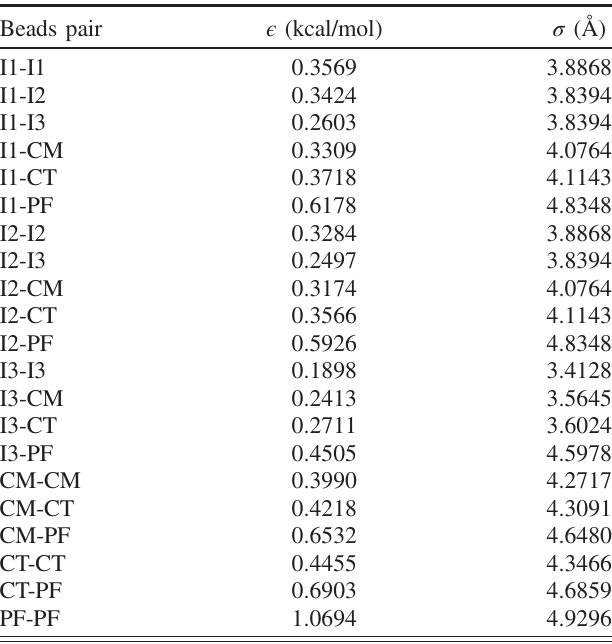
TABLE II. Force-field parameters used in the simulations. We have considered the values in Ref. [23], by doubling the value of ϵ PF − PF , with σ PF − PF unchanged. Next, we have globally rescaled all σ ’ s by f σ ¼ 0 . 948 and all ϵ ’ s by f ϵ ¼ 0 . 95 and recalculated the interaction ’ s energy with PF by the usual mixing rule ϵ αβ ¼